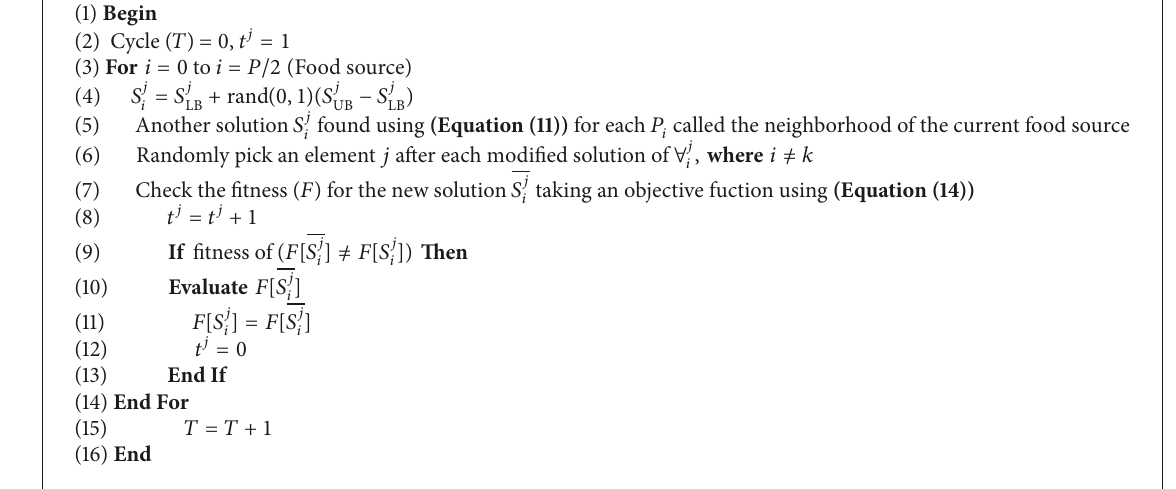
Algorithm 1: The modified employed bees.